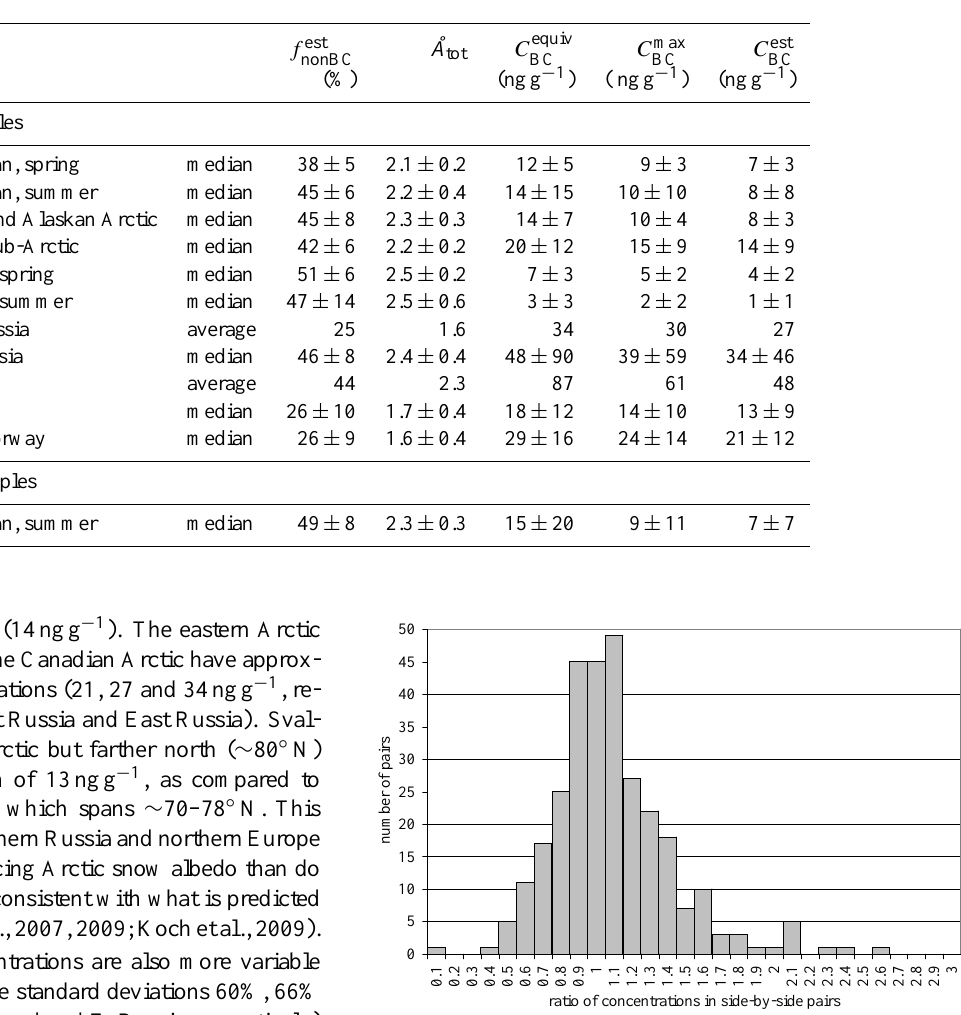
Table 2. Median values for surface snow and sea ice samples within a given region; for western Russia an average is used because there are only three sites contributing to the average. Standard deviations (1 σ) are also given where more than six values are available. Samples where surface snow had experienced melt are excluded; they are given in other tables. Data from Vorkuta are not included for Western Russia because Vorkuta is a large industrial city, and we judged the sampling locations to be insufficiently distant from the city to be regionally representative. The sea-ice samples are of the top surface of the sea ice after the snow has melted.